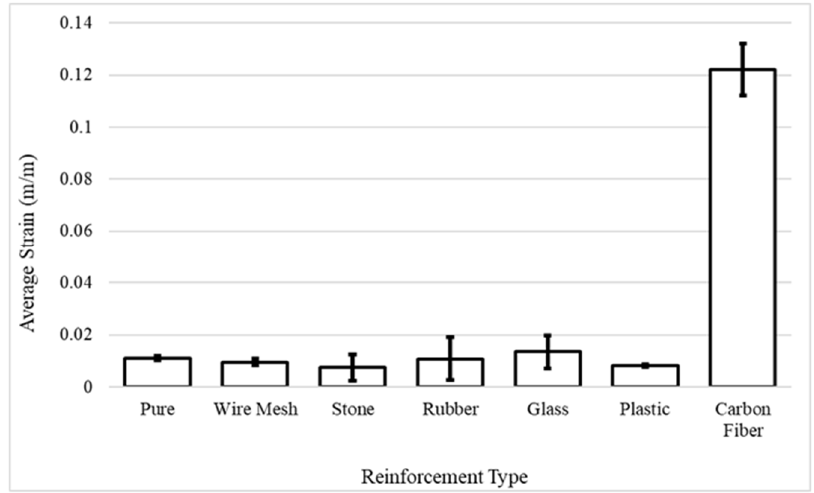
Figure 7. Average Strain at Failure for Each Reinforcement Type .